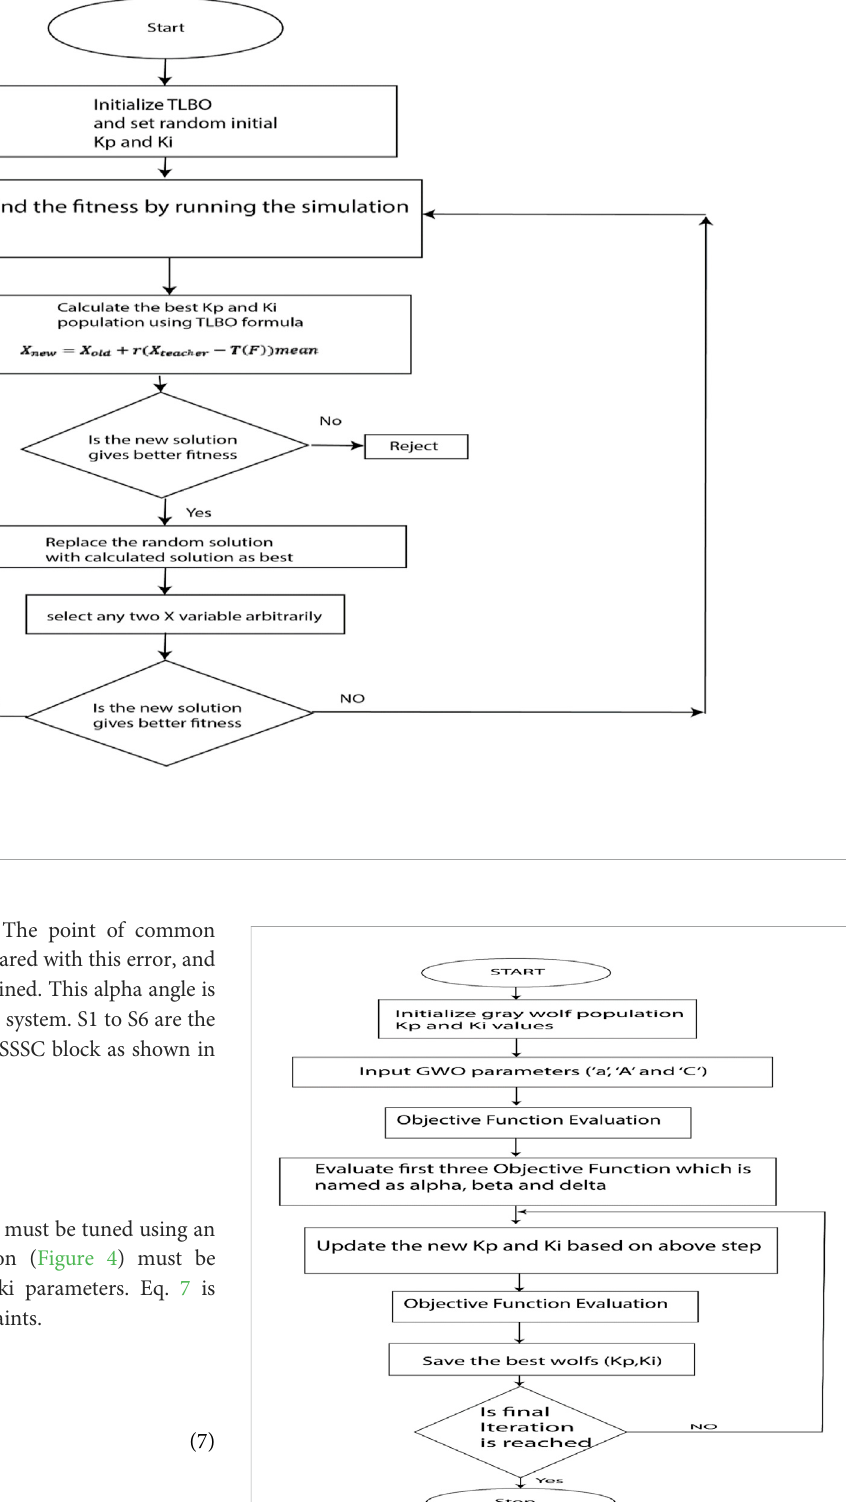
FIGURE 6 Proposed GWO-based tuning procedure fl ow